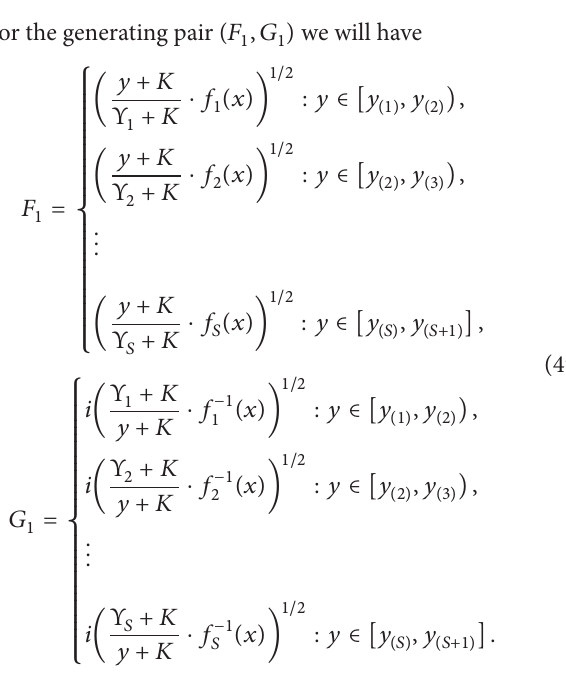
Table 3: Relation between the error E and the number of sections 𝑆 and samples per section 𝐶 , when 𝜎 = 𝑒 𝑥+𝑦 . Number of Points per radii 𝑅 radius 𝑃 sections 𝑆